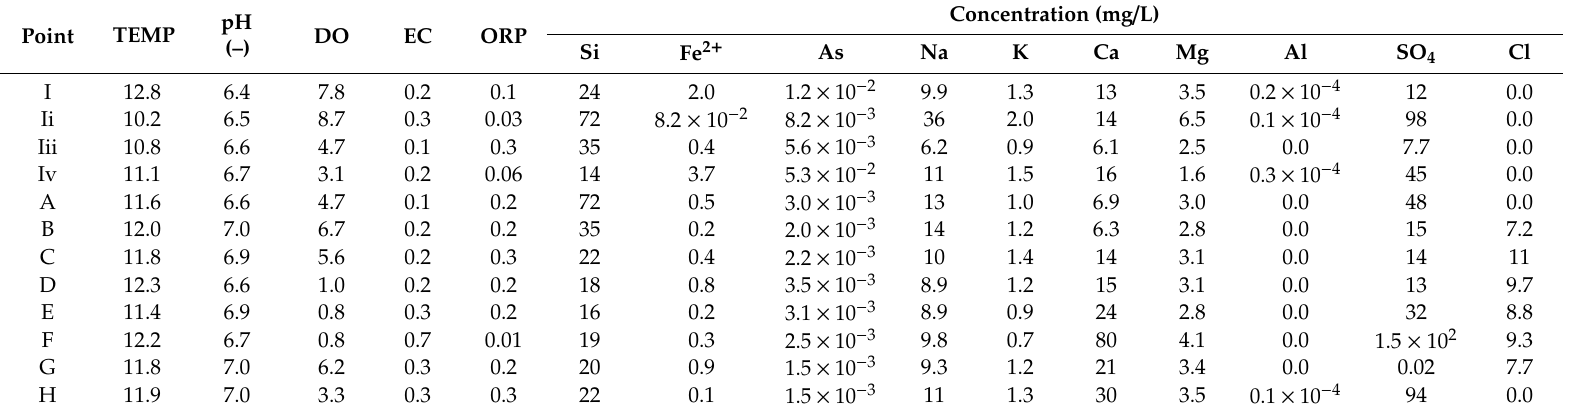
Table 4. Properties of the water sample obtained during field survey in winter